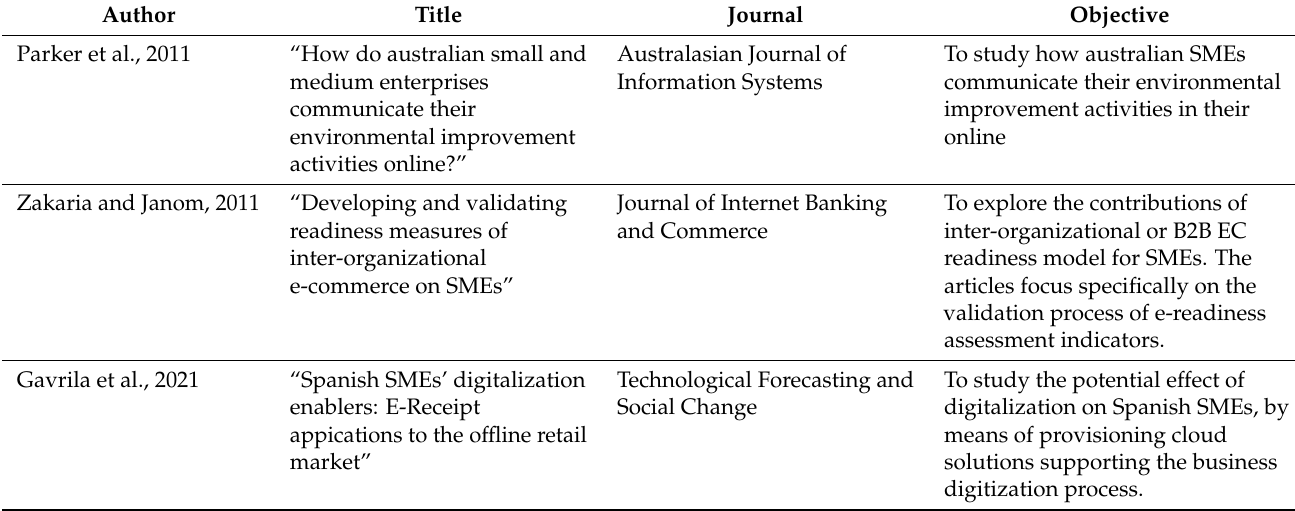
Table 4. Articles regarding the dimension of policymakers and governmental support in EC